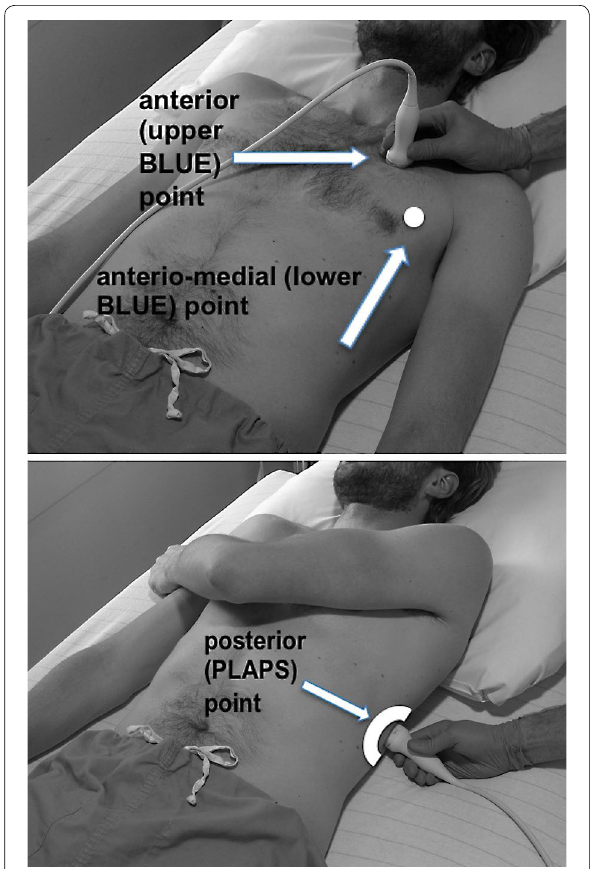
Fig. 1 BLUE and PLAPS points. Anterior (upper BLUE) point. Anteromedial (lower BLUE) point. Posterior (PLAPS) point